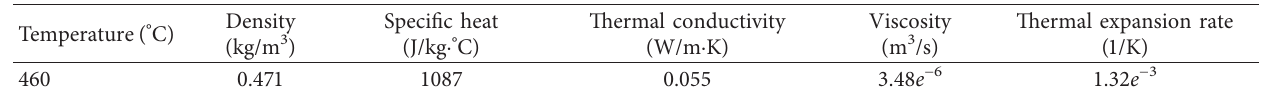
Table 4: Basic thermal physical parameters of air (485 °